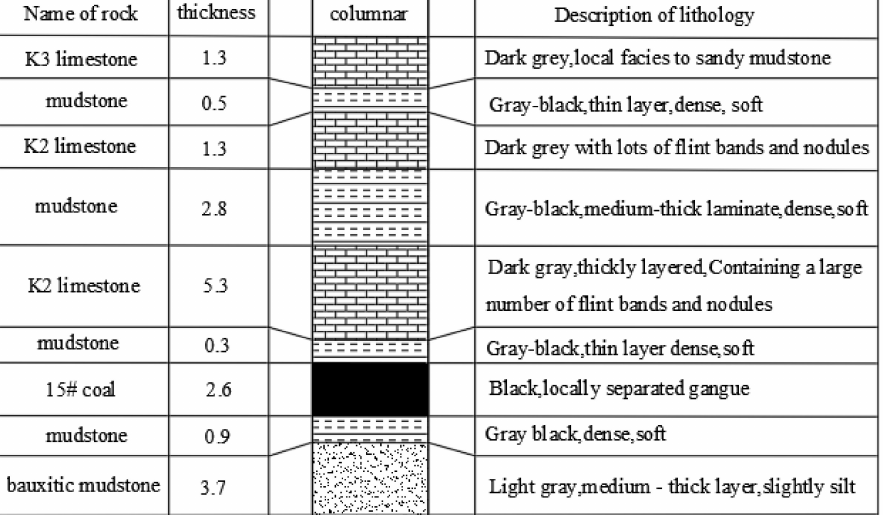
Figure 3. Comprehensive bar chart of the 1301 working face.